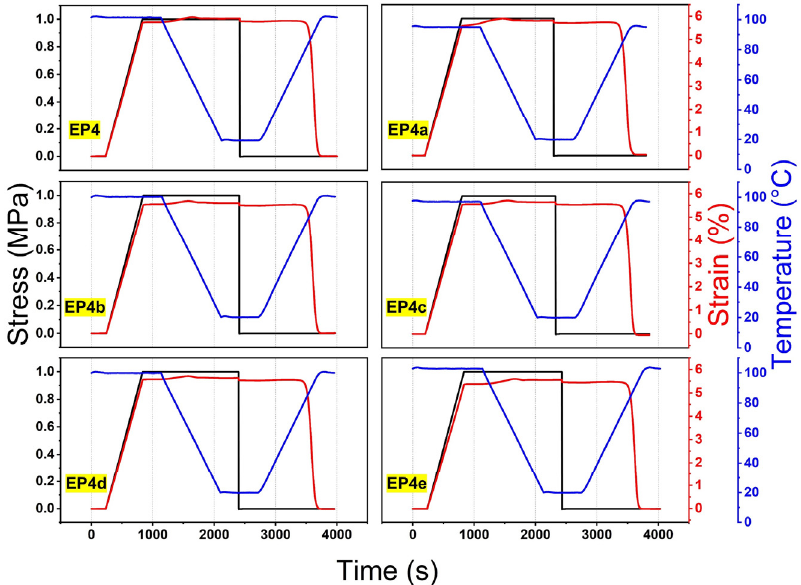
Figure 8. Shape memory cycle curves of SMEPNs with different ANCs loading amounts (EP4, EP4a, EP4b, EP4c, EP4d, EP4e, respectively, correspond to 0.00, 0.02, 0.06, 0.20, 0.40, 0.60 wt.% ANCs incorporated in matrix with mole ratio of epoxy monomer to curing agent 𝜂 = 1.75).